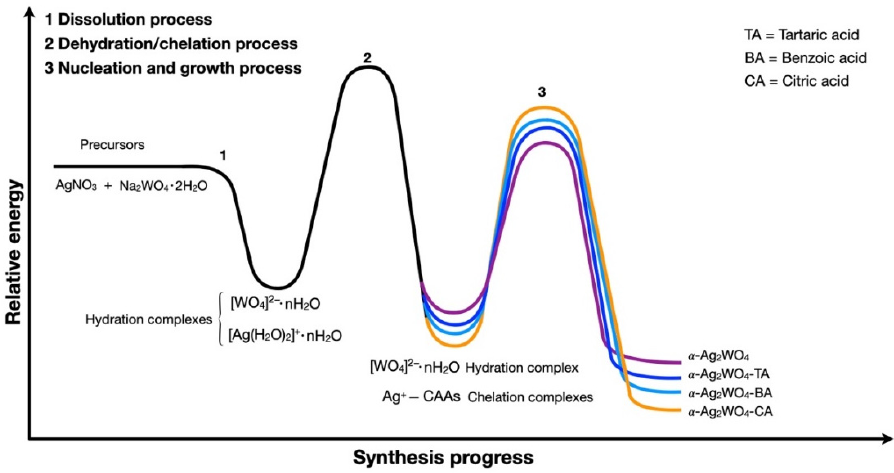
Figure 5. Schematic representation of the energy profiles for the synthesis progress.